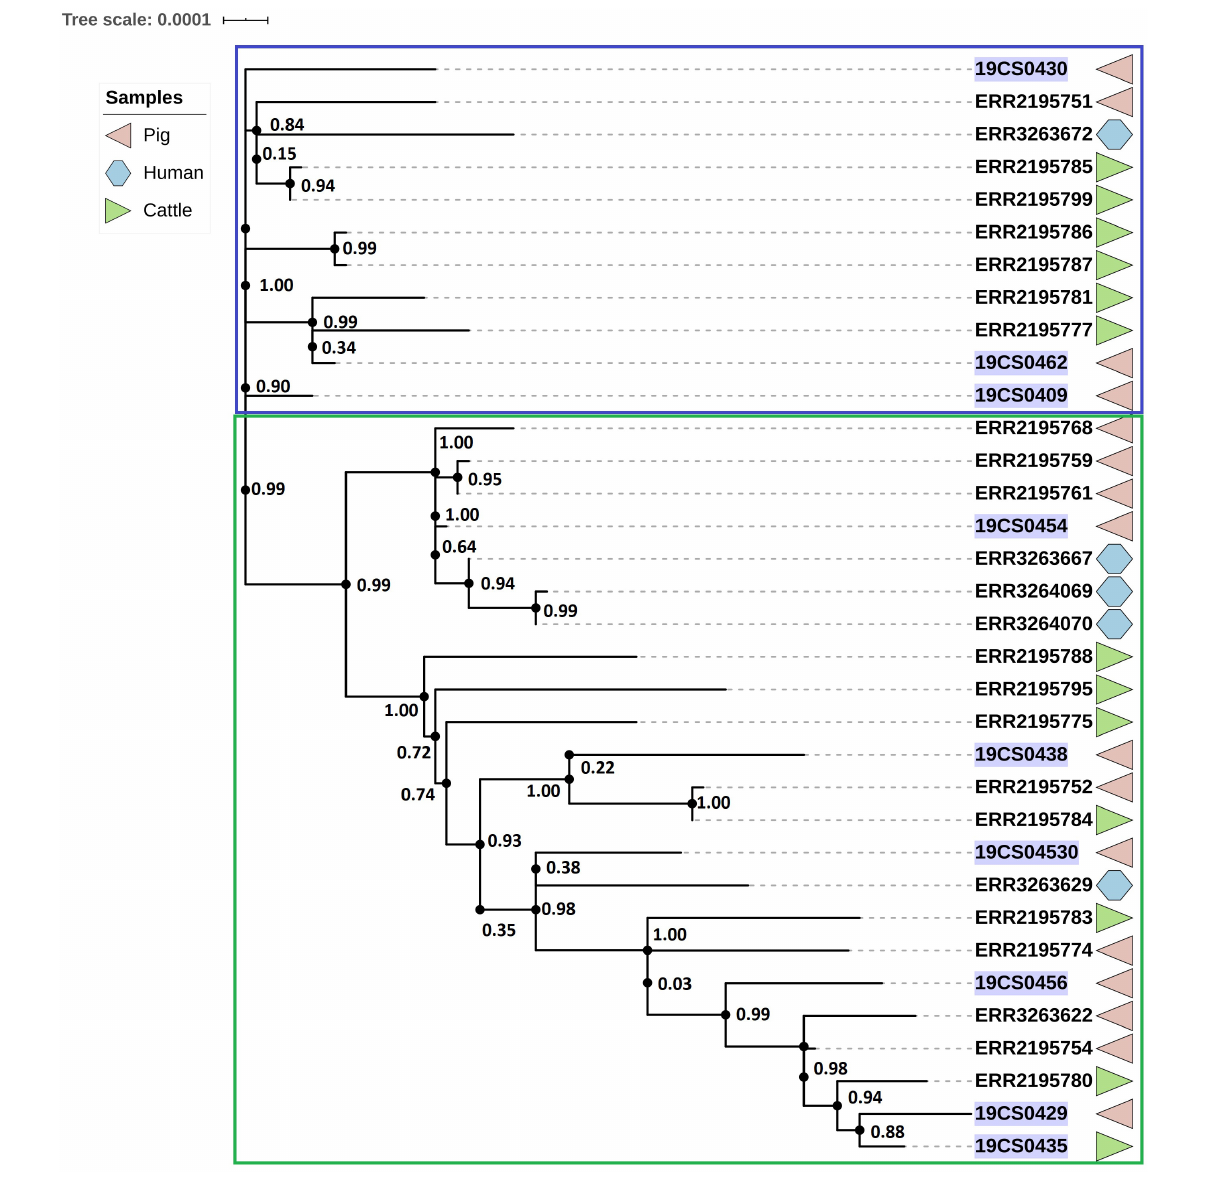
associated with resistance to β -lactam-antibiotics ( bla TEM − 1